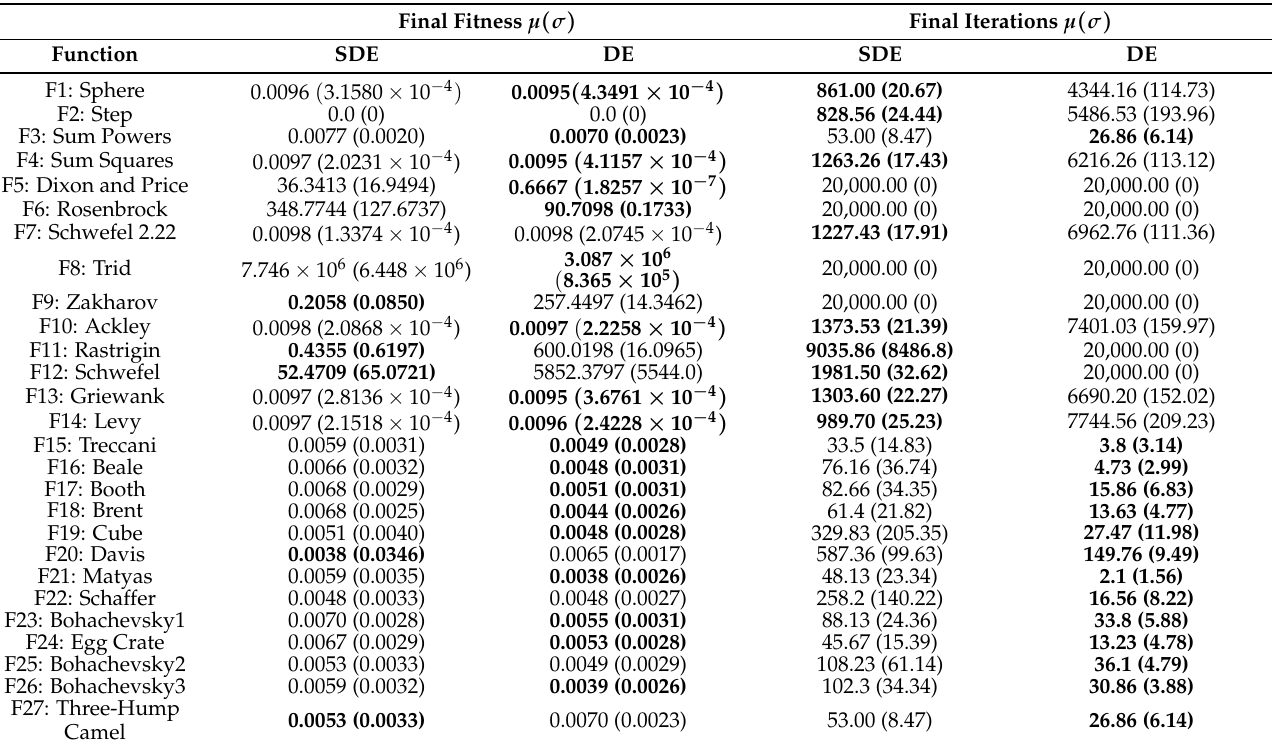
Table 8. Mean and averaged final fitness and iterations of DE and SDE ( N p = 512; D = 100). Final Fitness µ ( σ ) Final Iterations µ ( σ